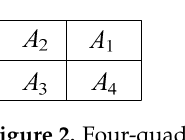
Figure 3. ( a ) Reflection and transmission coefficients of the TE 10 -mode-excited rectangular feed. ( b ) Reflection and transmission coefficients of the probe-excited rectangular feed. Figure 4a,b show the E - and H -plane directivity patterns of the sum channel. The maximum directivity of the sum channel is 13.4, 13.7, 14.3, and 14.8 dB at 14, 15, 16, and 17 GHz, respectively. The sidelobe level is less than –10.3 dB at 14–17 GHz in both E and H planes. The E - and H -plane 3-dB beamwidths are 52.2 º , 29.2 º at 14 GHz; 48.2 º , 27.3 º at 15 GHz; 41.6 º , 25.1 º at 16 GHz; and 36.3 º , and 23.3 º at 17 GHz. The E - and H -plane 10-dB beamwidths are 86.24 º , 48.27 º at 14 GHz; 78.65 º , 45.39 º at 15 GHz; 73.6 º , 42.13 º at 16 GHz; and 70.33 º , and 39.2 6º at 17 GHz. Figure 5a shows the directivity patterns of t he elevation difference channel. The result shows a directivity of 11.3 dB at 14 GHz; 11.6 dB at 15 GHz; 11.7 dB at 16 GHz; and 11.5 dB at 17 GHz. The sidelobe level is less than –19.6 dB at 14–17 GHz. The directivity of the azimuth difference channel is shown in Figure 5b. The result shows a directivity of 10.6